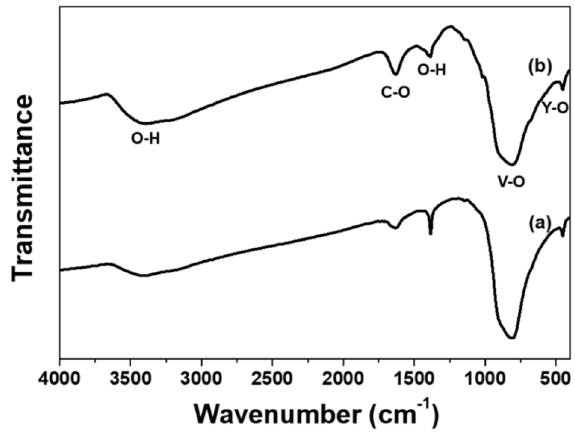
Figure 3. FT-IR spectra of YVO 4 :Eu 3 + nanoparticles hydrothermally grown using the precursor solutions at (a) pH = 7 and (b) pH = 10.